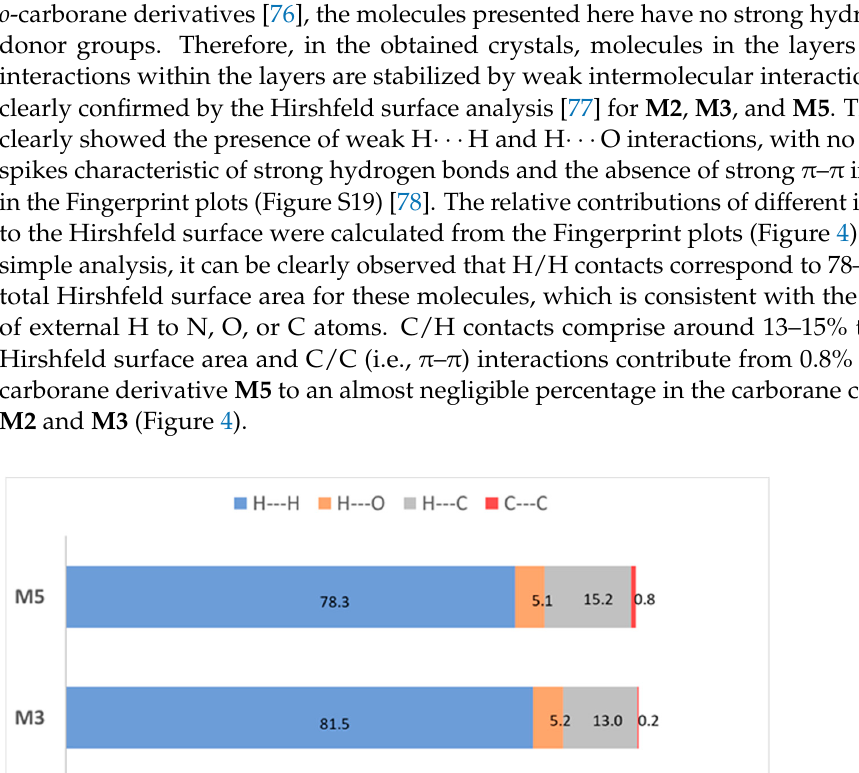
Figure 4. Relative contributions of various intermolecular contacts to the Hirshfeld surface area in all compounds in this study.